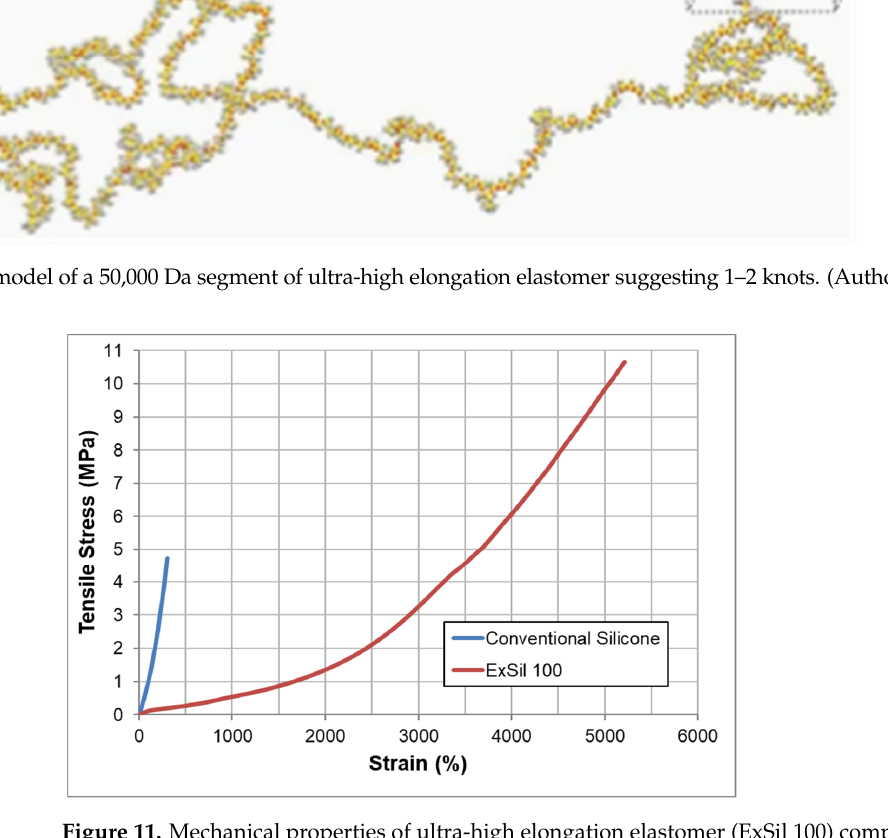
Figure 11. Mechanical properties of ultra-high elongation elastomer (ExSil 100) compared to conventional silicone elastomer.